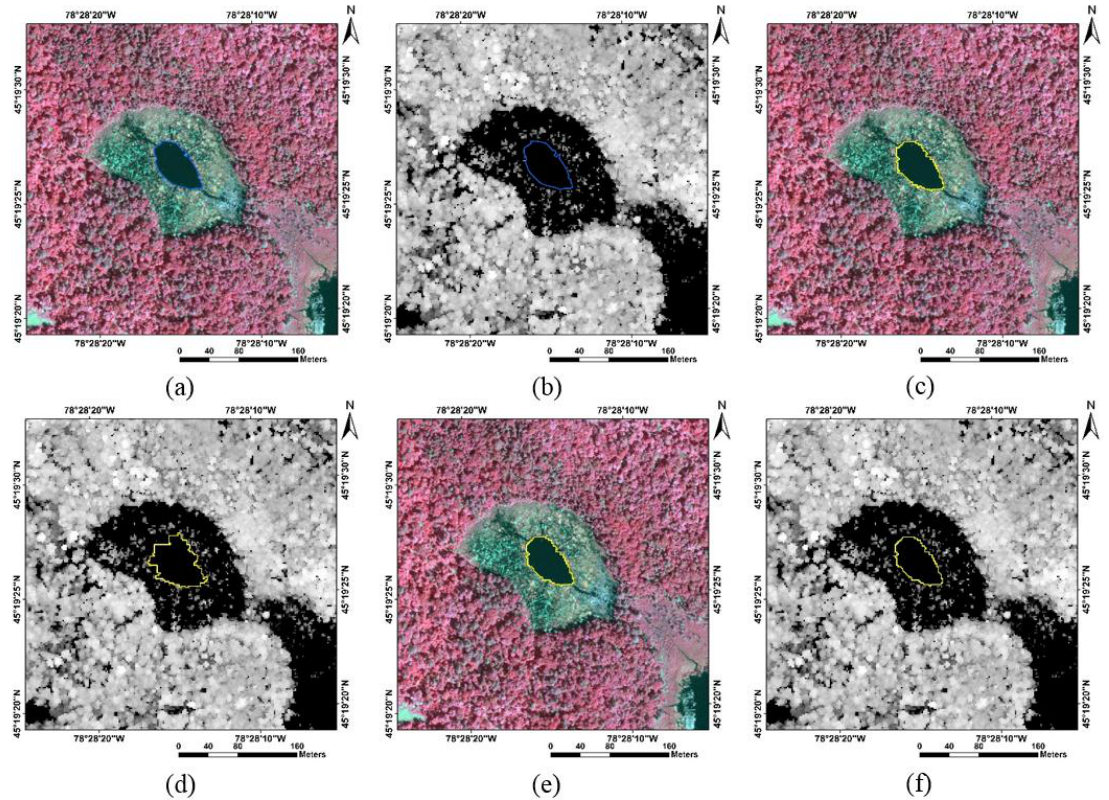
Figure 5. Examples of non-forest gap segmentation results by different data sources. Tile ( a ) and ( b ) show the reference geo-objects (blue polygons) of non-forest gaps imposed on the multispectral image and CHM, respectively. Tile ( c ) depicts the result of segmentation using the multispectral image at the optimal scale parameter of 10, while Tile ( d ) indicates the corresponding segments by segmenting the CHM at the optimal scale parameter of 20. Both Tile ( e ) and ( f ) show the optimal segmentation result through the integration of multispectral image and CHM at the scale parameter of